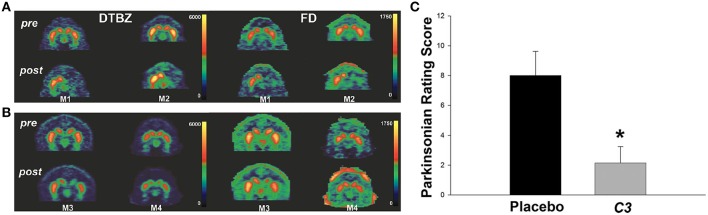
(A,B) Positron emission tomography (PET) brain images using from two control primates (M1, M2) and two carboxyfullerene-treated primates (M3, M4) before MPTP injection (pre) and at the end of the treatment (post). [11C] dihydrotetrabenazine (DTBZ) and 6-[18F] fluorodopa (FD) are used as probe for evaluating the nigrostriatal dopaminergic activity. As clearly visible placebo-treated animals are showing unsymmetrical distribution of tracers in the two hemispheres indicating partial loss of dopaminergic activity, while carboxyfullerene-treated animals are showing dopaminergic activity in both the hemispheres. (C) Parkinsonian rating score at the end of the treatment, indicating reduction of bradykinesia in carboxyfullerene (C3) treated animals with respect to animals receiving placebo. Data reported as mean + s.e.m. *p = 0.007. Adapted from Dugan et al. (2014) with permission from John Wiley and Sons, Copyright (2014).